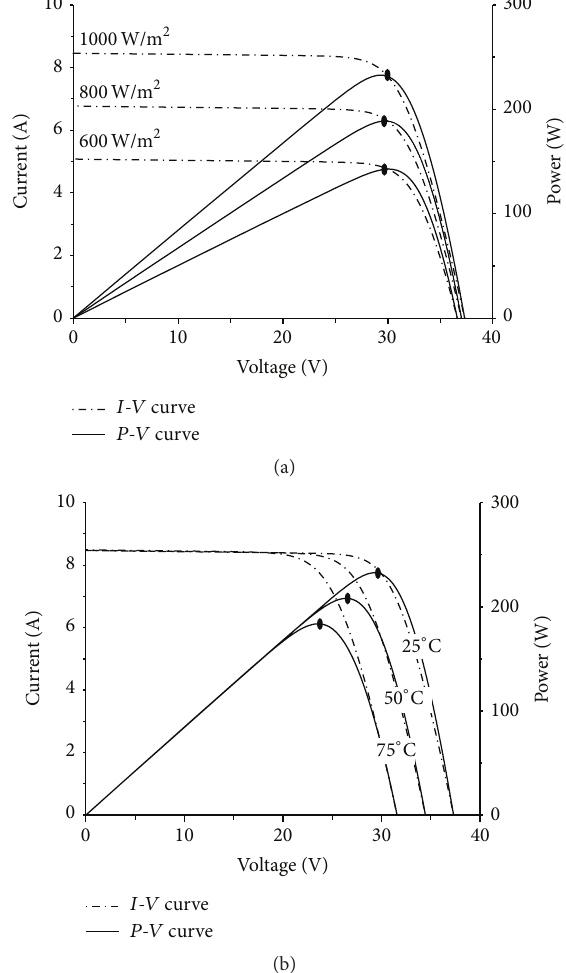
Figure 2: I-V and P-V characteristic for SG-2300 under (a) various irradiation, 𝑇 =25 ∘ Cand(b)differentpaneltemperature,irradiation at 1000W/m 2